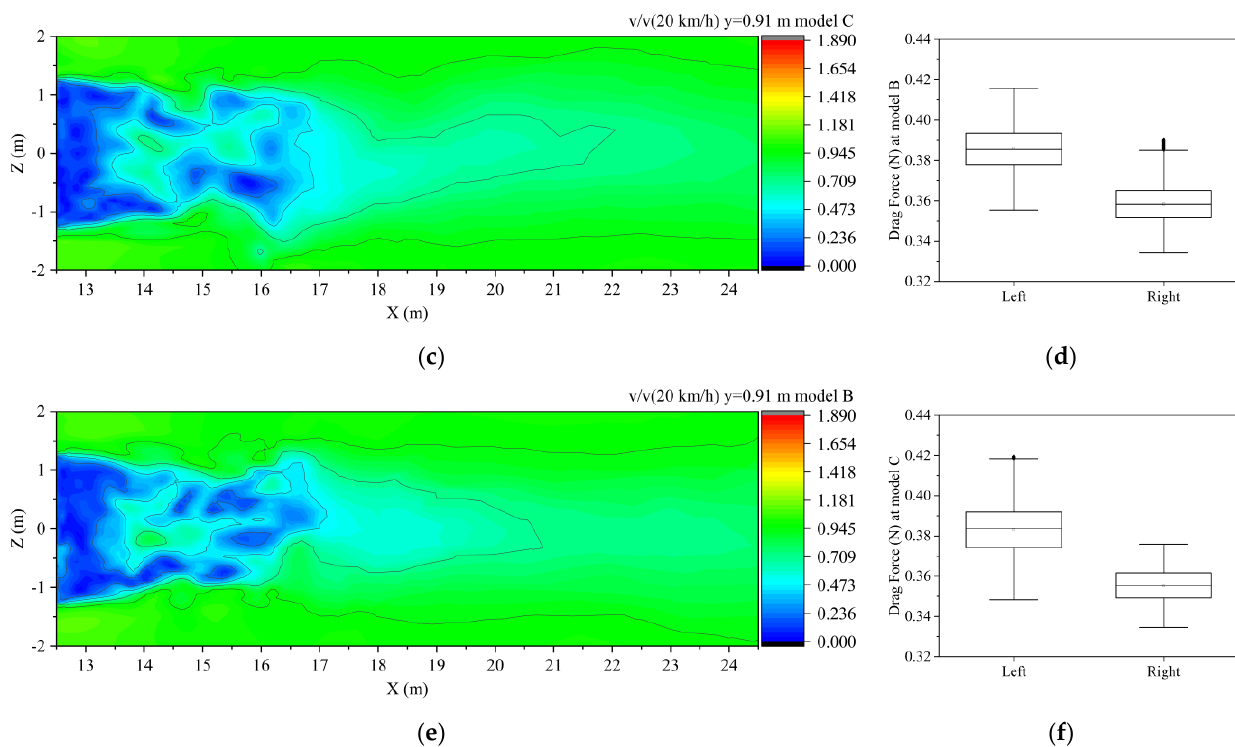
Figure 8. Horizontal (Z-X plane) velocity distribution for ( a ) model A at Y = 0.91 m; ( c ) model B at Y = 0.91 m; ( e ) model C at Y = 0.91 m and drag forces on the sides for ( b ) model A; ( d ) model B; ( f ) model C